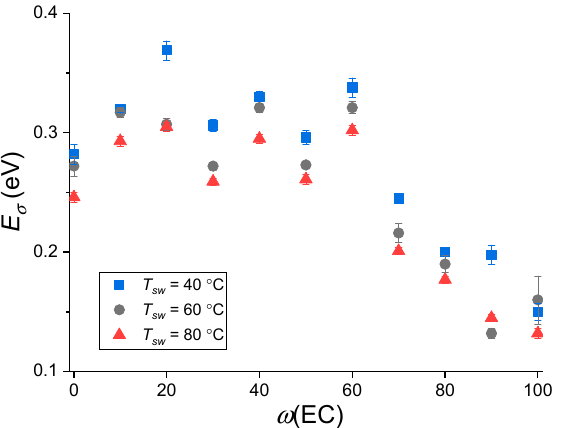
Figure 6. Dependence of the activation energy of conductivity on the EC content in mixture EC–SL above the kink temperature.